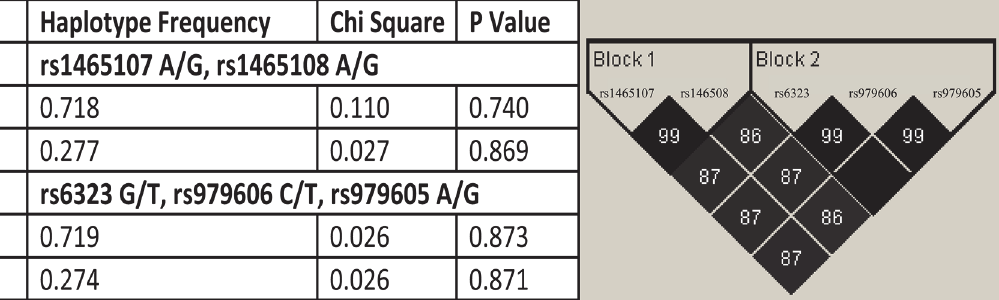
Fig 2. Monoamine oxidase A haplotype Block comprises SNPs rs1465107 and rs1465108 and Block 2 comprises the SNPs rs6323, rs979606, and rs979605. 1 composed by single nucleotide polymorphisms evaluated. Darker squares mean the high D prime and high LOD scores. Haplotype blocks were defined with D prime scores higher than 95. When D prime is 100, the number is not shown inside the square. Data shown in the table refers to each haplotypes allele combination association